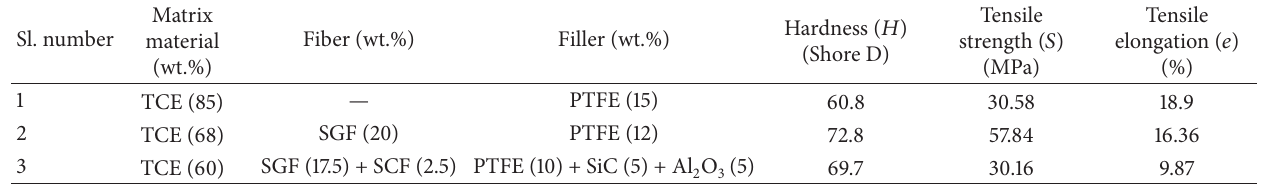
Table 2: Mechanical properties of TCE + PTFE filled hybrid composites. Sl.